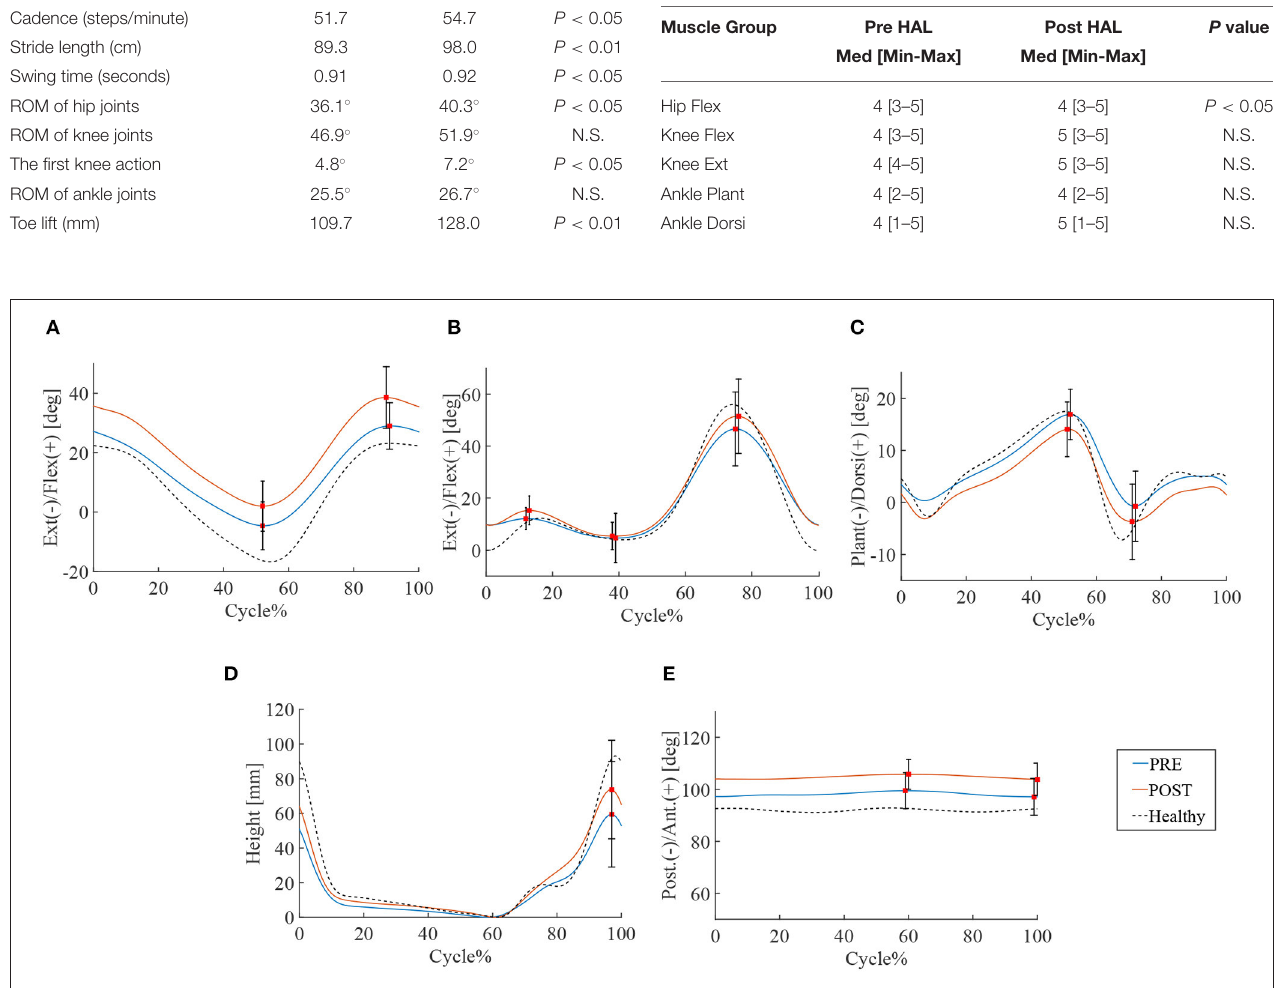
Frontiers in Neurorobotics |